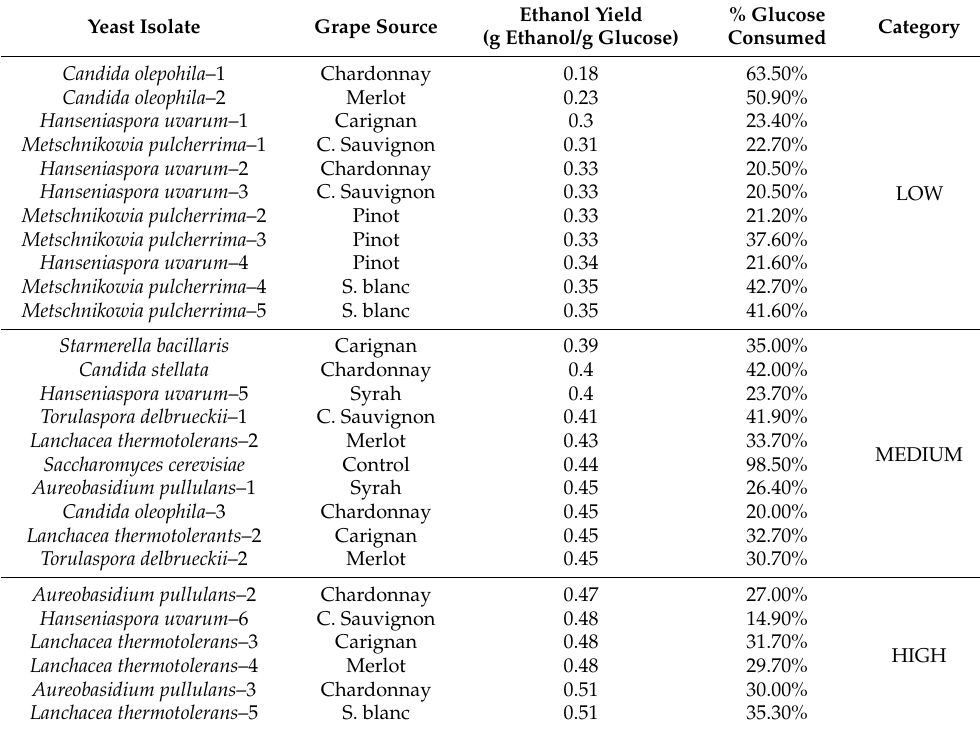
Table 5. Ethanol yield and sugar utilization of non- Saccharomyces yeast